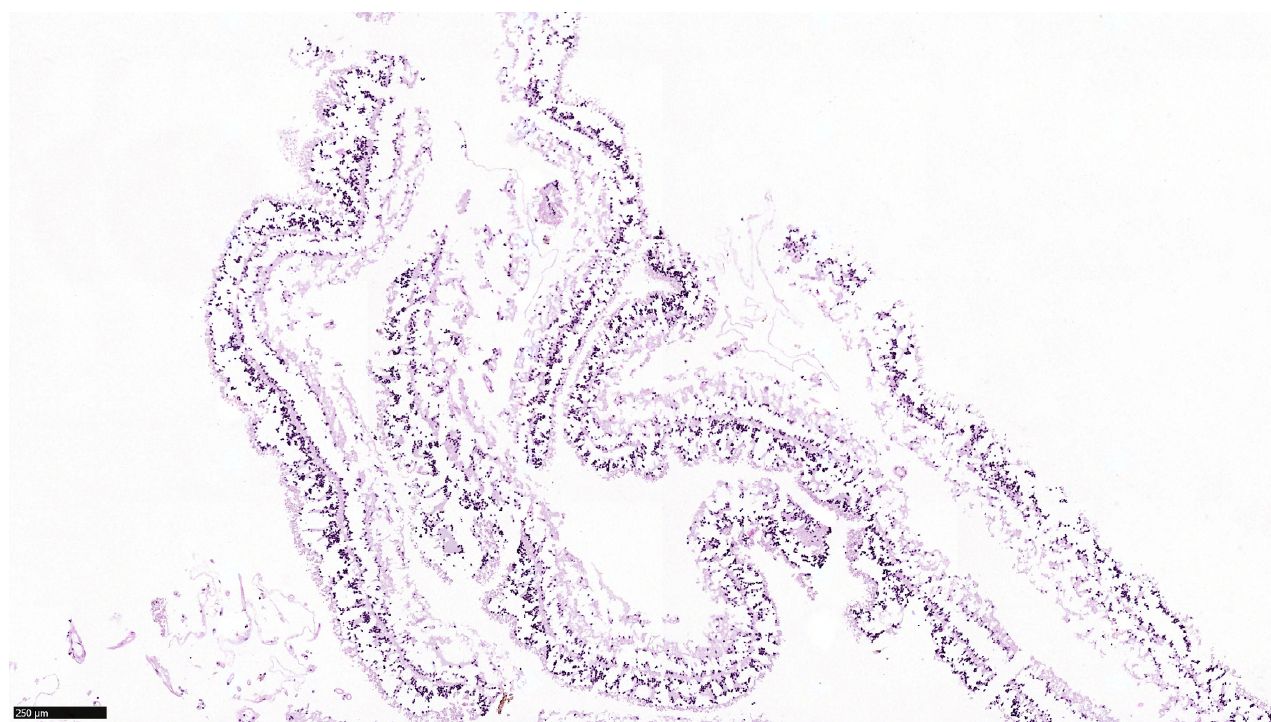
Figure 8. Artificially detached normal appearing retina with lytic changes, which rather represent a freeze-thawing artifact. The artificial detachment is due to pre-freezing manipulation to obtain microbiological samples (Periodic acid Schiff stain, bar = 250 µm).